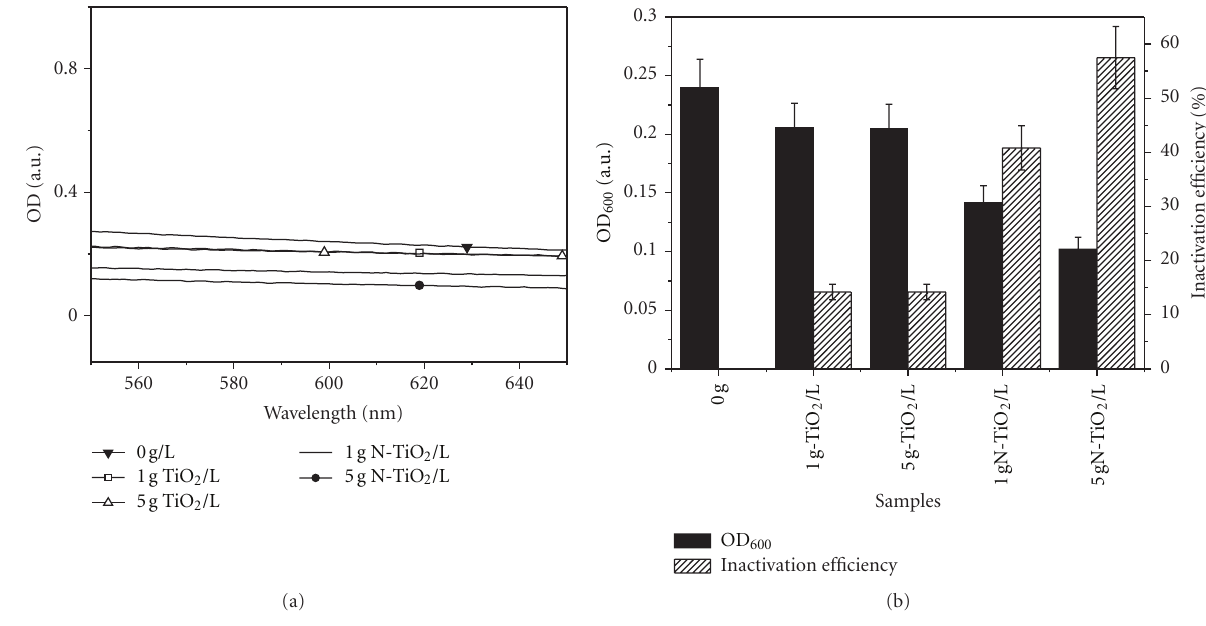
Figure 4: Inactivation e ffi ciency of commercial TiO 2 and N-doped TiO 2 . TiO 2 power has a pale yellow color, and both samples are anatase crystalline